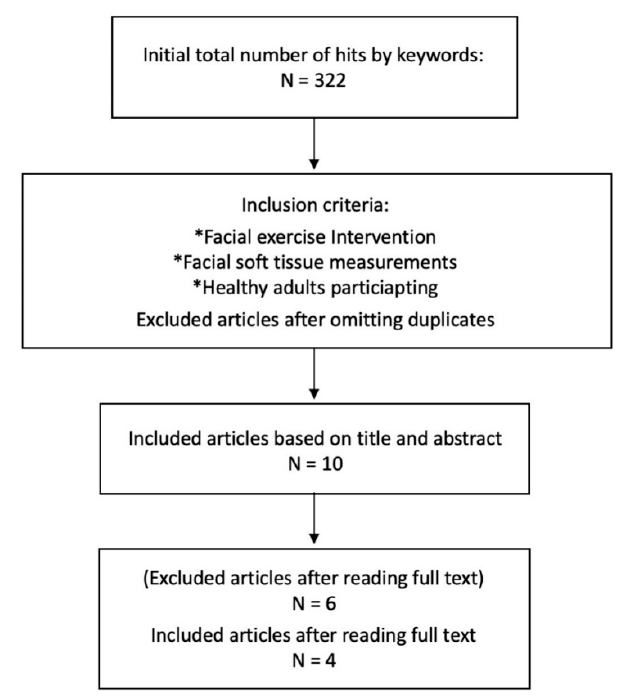
Figure 1. Flowchart of the literature search.